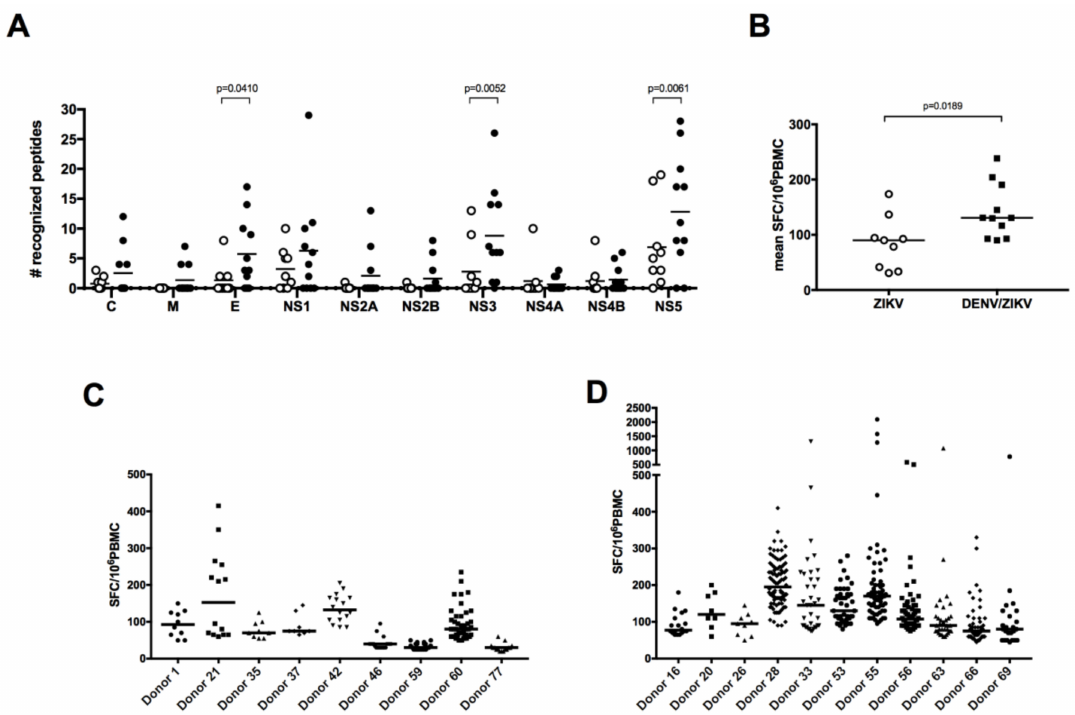
Figure 2. DENV/ZIKV-immune donors reveal a broader T-cell response with a higher magnitude. ( A ) Breadth and ( B ) magnitude of responses in donors with a history of ZIKV infection only or DENV and ZIKV infection. Each dot represents one donor (open circles, ZIKV-immune DENV-naïve donors; filled circles, DENV/ZIKV-immune donors) and the bars represent the median value for each group of donors. The p values were calculated using the nonparametric two-tailed Mann–Whitney test. Frequency of responses against individual peptides, per donor, in ZIKV-immune DENV-naïve ( C ) and DENV/ZIKV-immune ( D ) donors. Each dot represents one peptide. The bars represent the median response for each